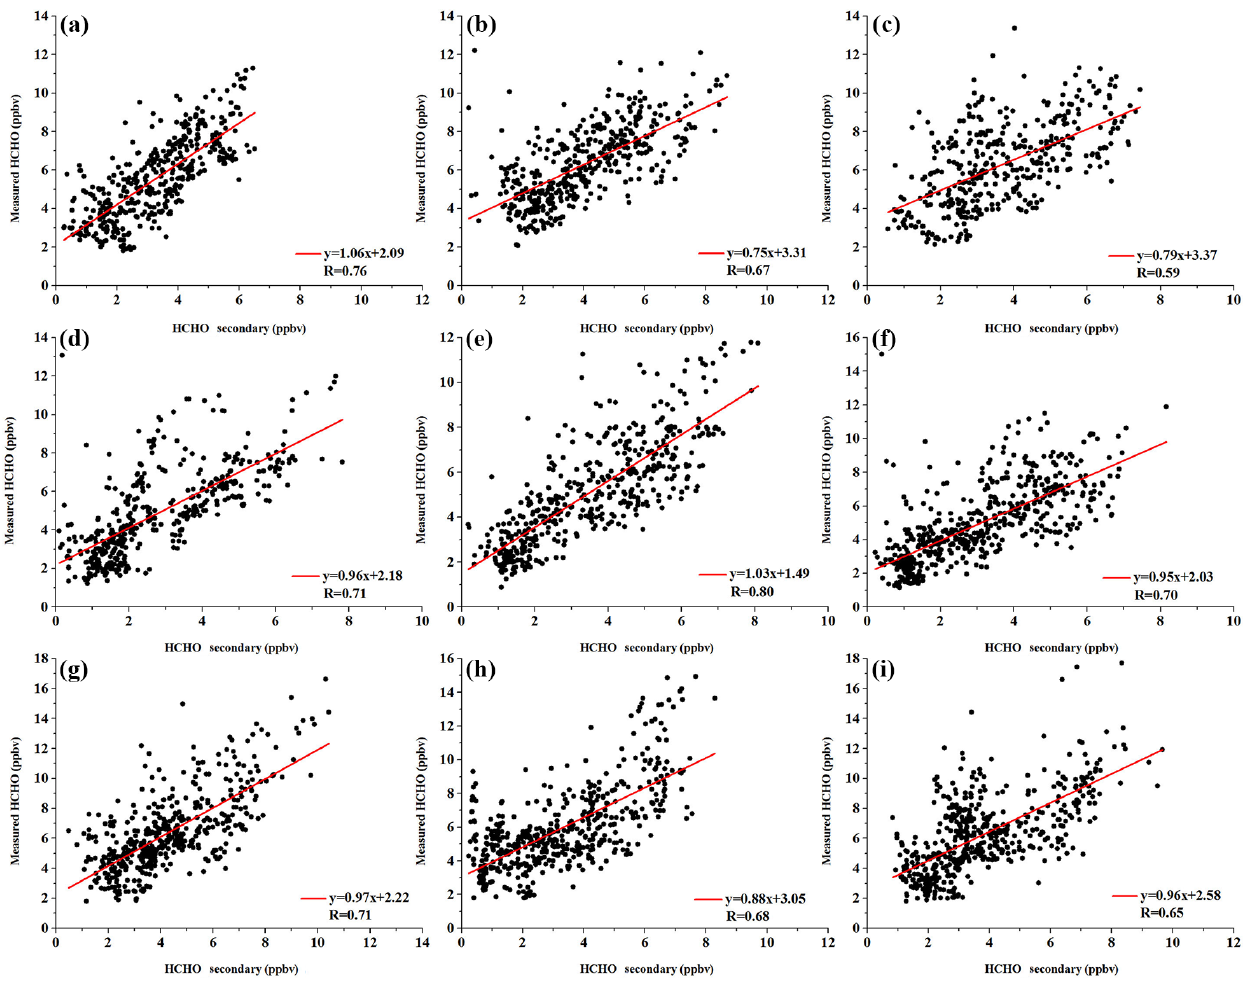
Figure 7. Correlation analysis of total HCHO and secondary HCHO from 2015 to 2017 at the RJR site (a) , the MGQ site (b) , and the XLUT site (c) in Nanjing; at the XS site (d) , the CXT site (e) , and the FDCH site (f) in Hangzhou; and at the HK site (g) , the PDNA site (h) , and the DSL site (i) in Shanghai (significance values are equal to